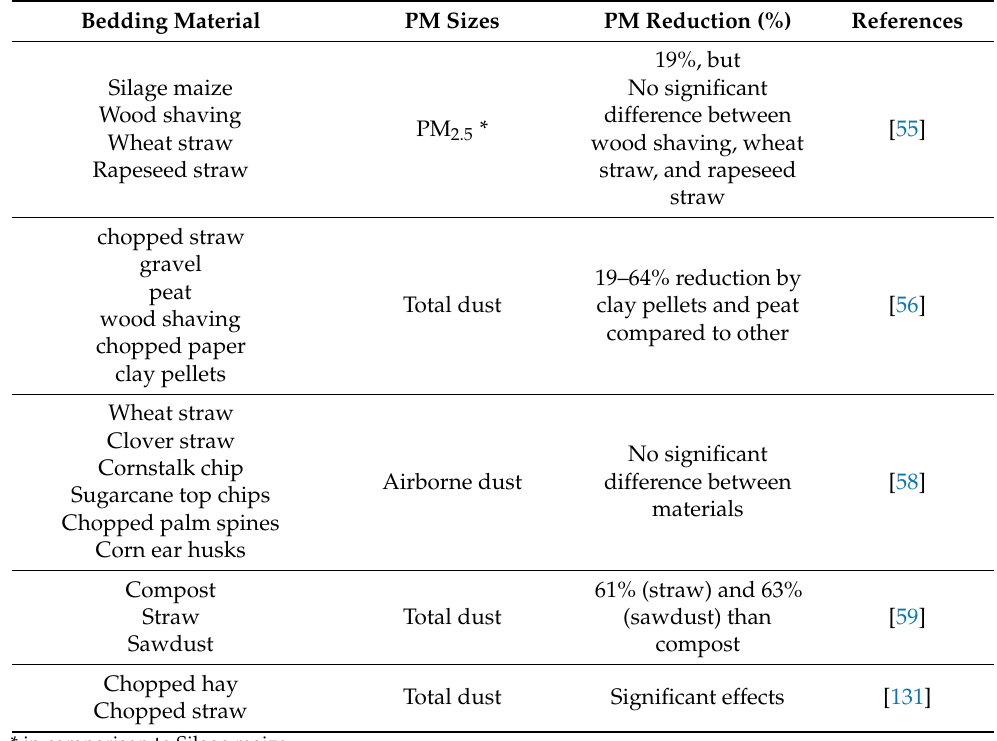
Table 11. Particulate matter reduction by using different kinds of bedding materials.